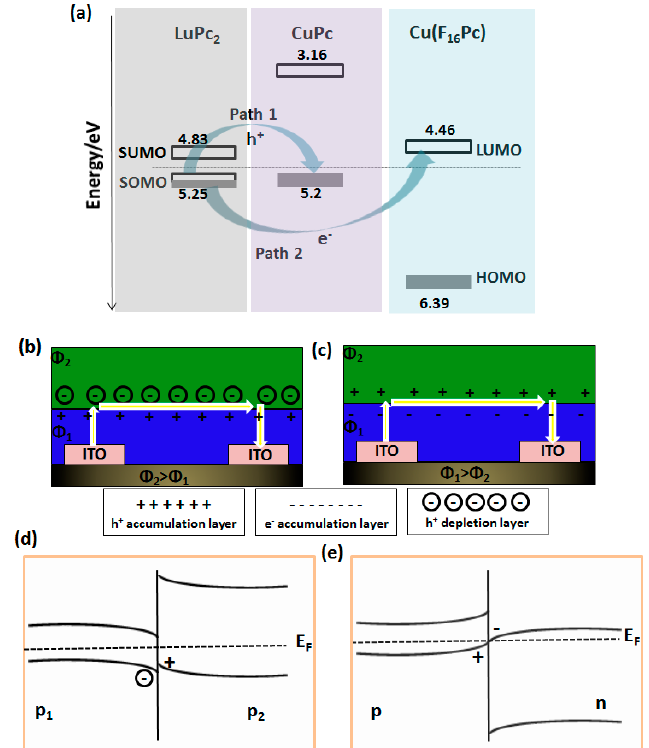
Figure 4. Charge transfer pathways between energy levels at the interface of CuPc/LuPc 2 (path 1) and Cu(F 16 Pc)/LuPc 2 (path 2) heterojunction. The energy of frontier molecular orbitals of different MPc are depicted ( a ). The redistribution of charge carriers at the interface and induced band bending are shown, if Φ top layer > Φ sublayer ( b ) and ( d ) and Φ top layer < Φ sublayer ( c ) and ( e ). The legends at the bottom of (b) and (c) represent the nature of charge accumulation layer at the interface (Adapted from [47,53]). As a consequence of e − and h + hopping between the frontier orbitals of MPcs, the charges are redistributed at the interface. Because of the h + transfer from LuPc 2 to CuPc in p-p isotype heterostructure, h + is depleted in LuPc 2 and accumulated in CuPc near the interface, forming a depletion/accumulation heterojunction (Figure 4b). The h + injection in CuPc causes upward HOMO